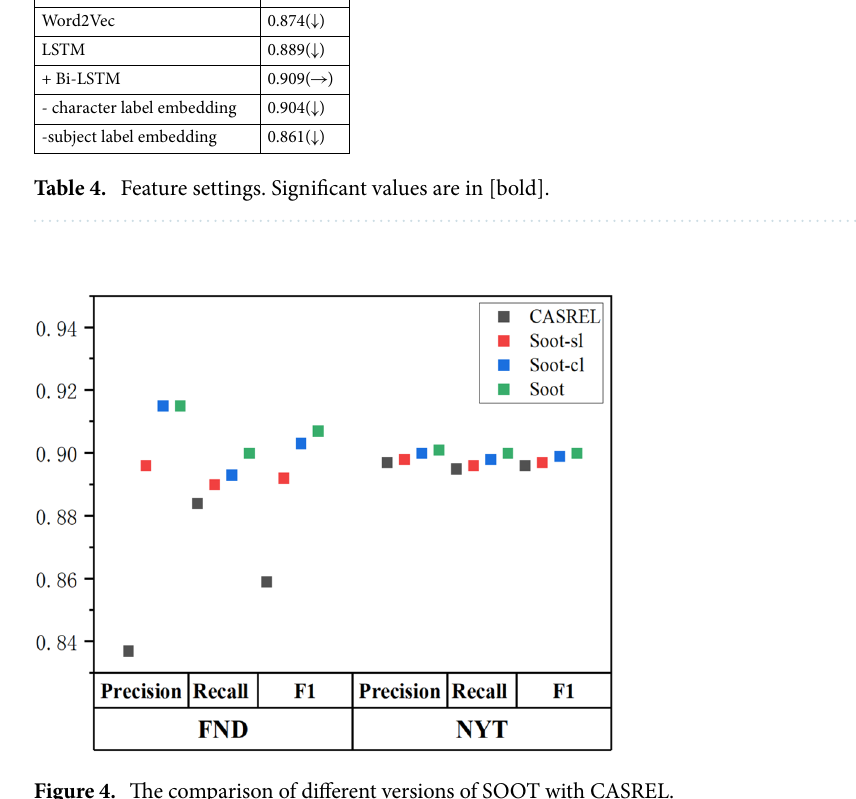
Figure 4. The comparison of different versions of SOOT with